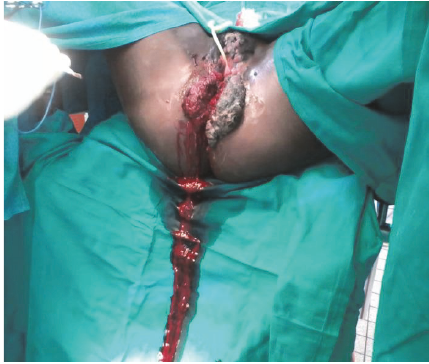
Figure 2: Giant condyloma acuminatum after surgical resection.